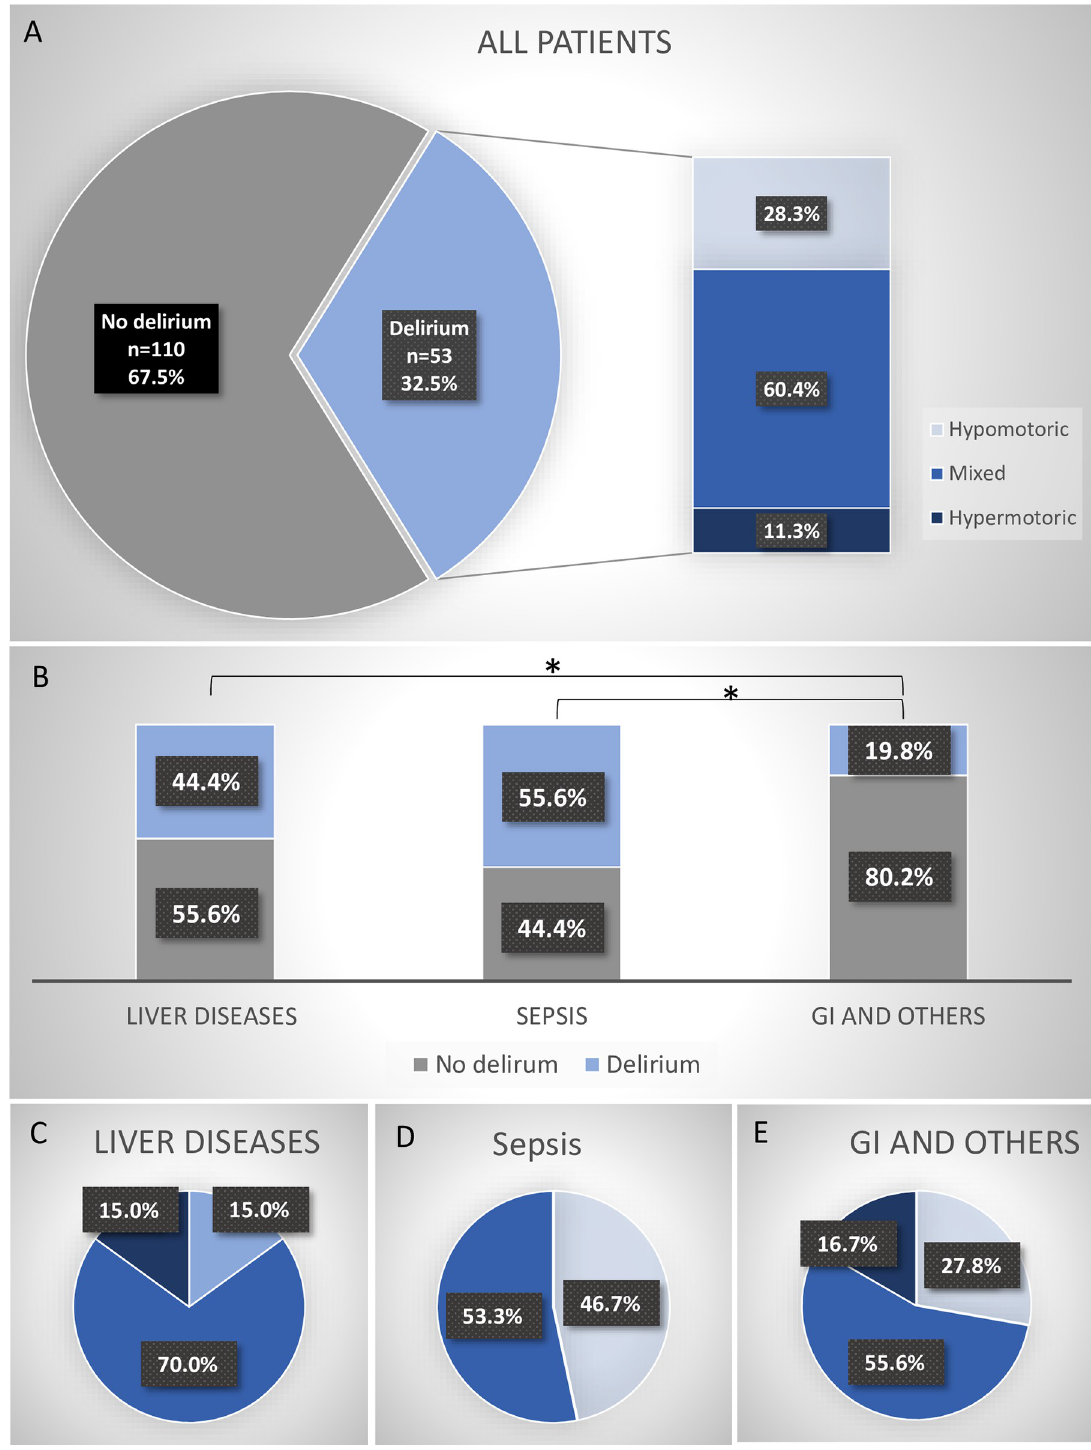
Fig 3. A: Incidence and motoric subtypes of delirium. B: Liver disease (p = 0,003) and sepsis (p = 0,016) are predictors for delirium. C: Motoric subtypes of delirium in patients with liver diseases. D: Motoric subtypes of delirium in patients with sepsis. E: Motoric subtypes of delirium in patients with GI and other diseases. GI =